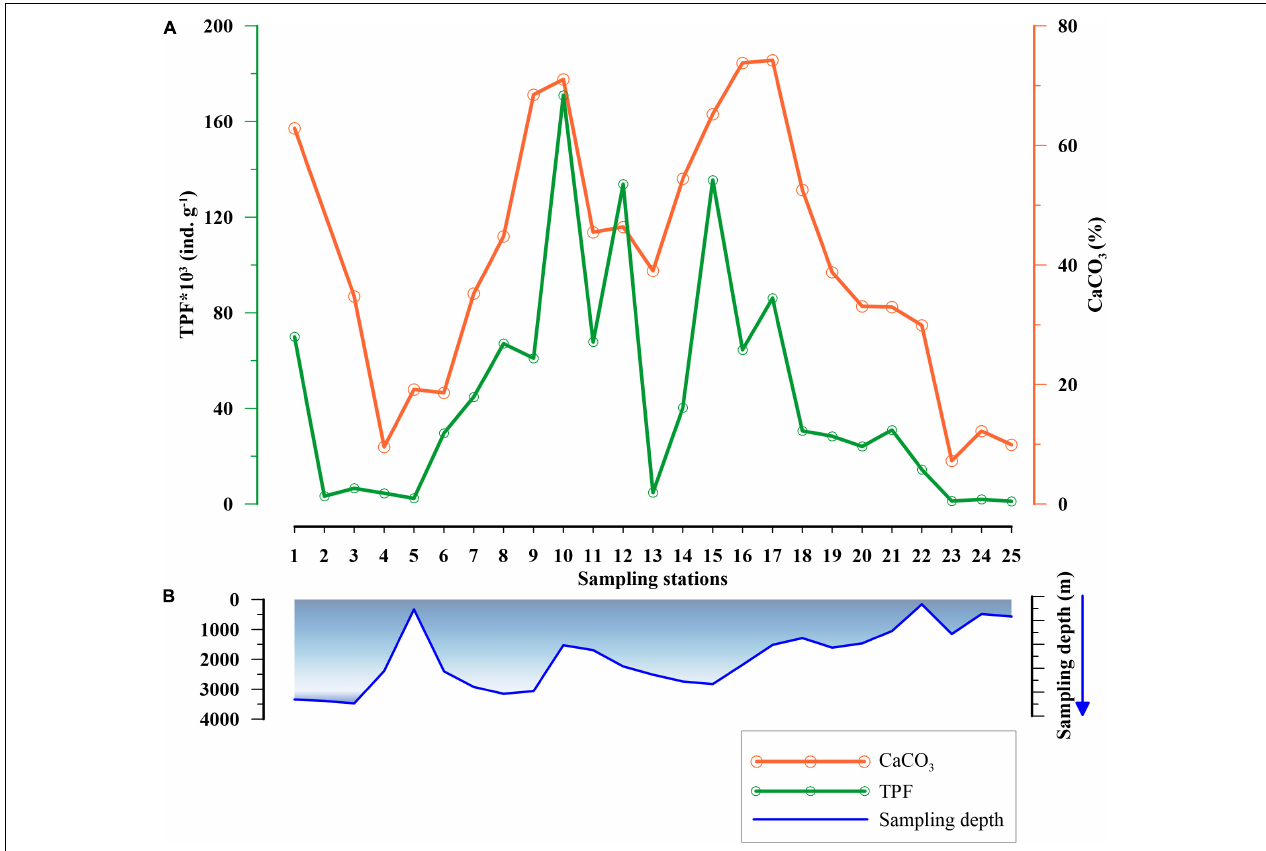
FIGURE 2 | (A) Variation in Total Planktic Foraminiferal (TPF) abundance in numbers per gram sediment (ind. g − 1 ) (in green) and calcium carbonate (CaCO 3 ) % (in orange) at different stations, and (B) the blue curve depicts the sampling depth (m) of the stations in the subpolar North Atlantic